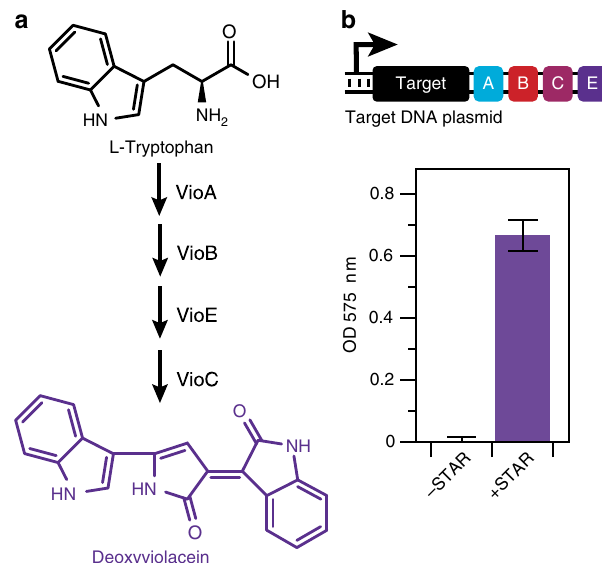
Fig. 4 STARs allow for control of multi-gene metabolic pathways. a Schematic of the four gene deoxyviolacein metabolic pathway ( vioABCE ) that converts L-tryptophan into the purple compound deoxyviolacein. b Schematic DNA template of a plasmid containing a STAR regulated vioABCE pathway. Characterization was performed on E. coli DH5 alpha pir cells transformed with this plasmid in the absence (-STAR) and presence (+STAR) of a plasmid encoding cognate STAR. Deoxyviolacein production was characterized by solvent extraction and spectral quanti fi cation of deoxyviolacein (measured in units of OD at 575 nm). Data represent mean values and error bars represent s.d. of n = 9 biological